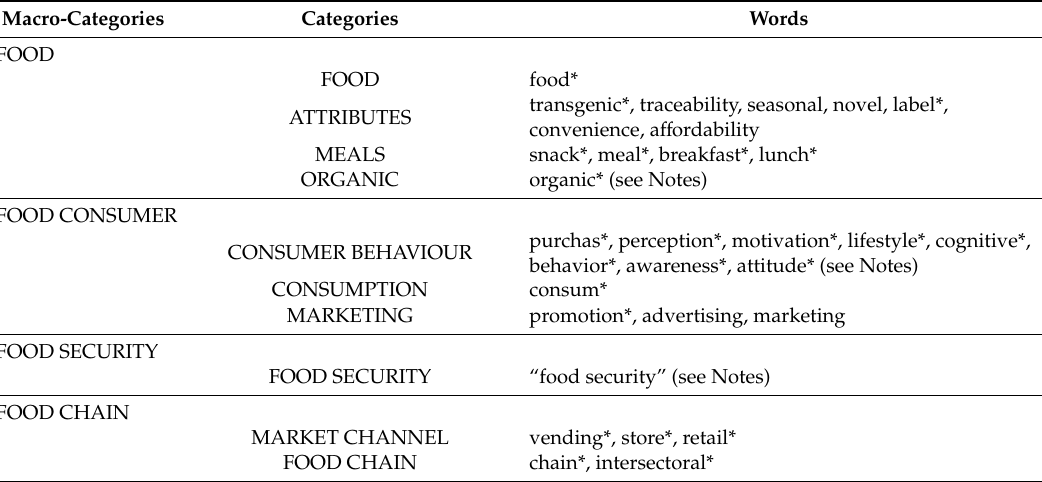
Table A3. Dictionary of Food dimension: Macrocategories, categories,